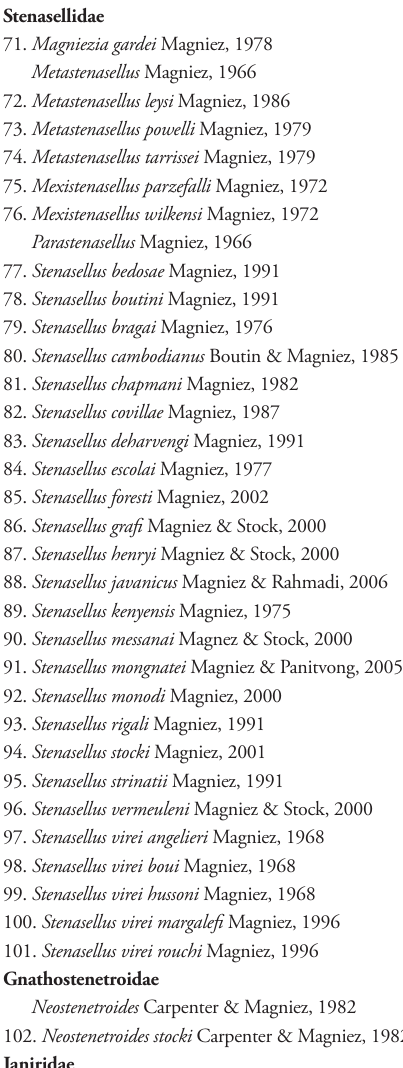
Table 1. List of genera, species and subspecies described or co-described by Guy Magniez. Numbers refer to the location of species and subspecies as indicated in Figure